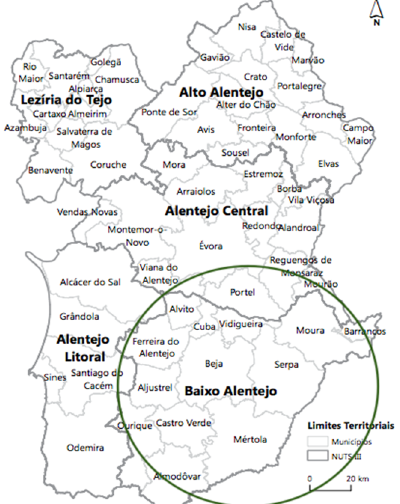
Figure 4. Map of the municipalities of NUTS II region of Alentejo, highlighting municipalities of Baixo Alentejo. Sources: author’s own elaboration based on INE (2021).